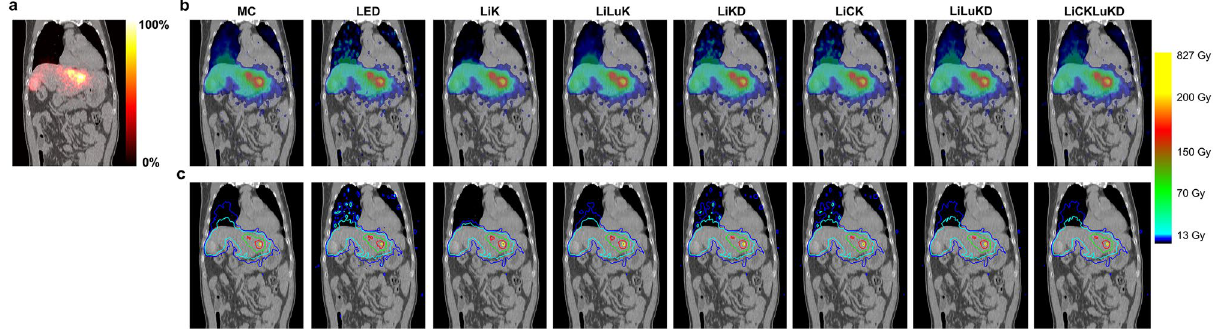
Figure 2. Coronal view of ( a ) the SPECT/CT fusion image, ( b ) the absorbed dose map and ( c ) isodose contour of a sample patient for MC and different VSV methods.